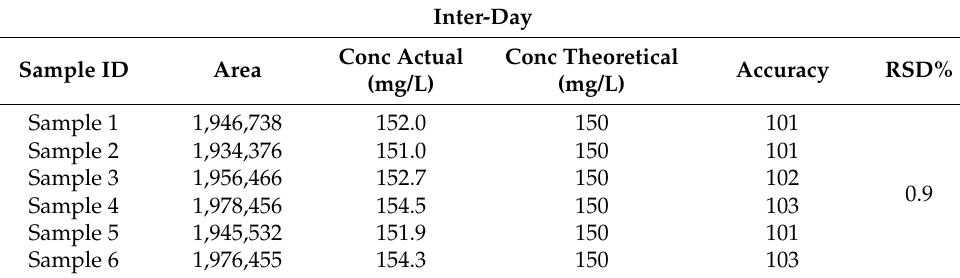
Table 7. Intermediate precision (Inter-day) of meloxicam.